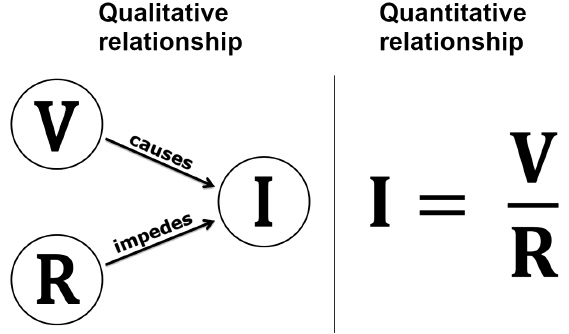
FIG. 14. Juxtaposition of the qualitative and quantitative relationship of voltage ( V ), resistance ( R ), and current ( I